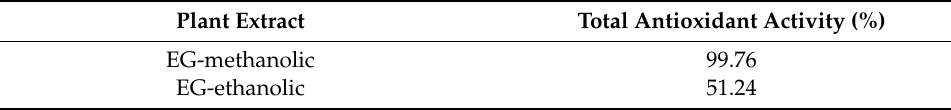
Table 6. Total antioxidant activity of plant extracts.